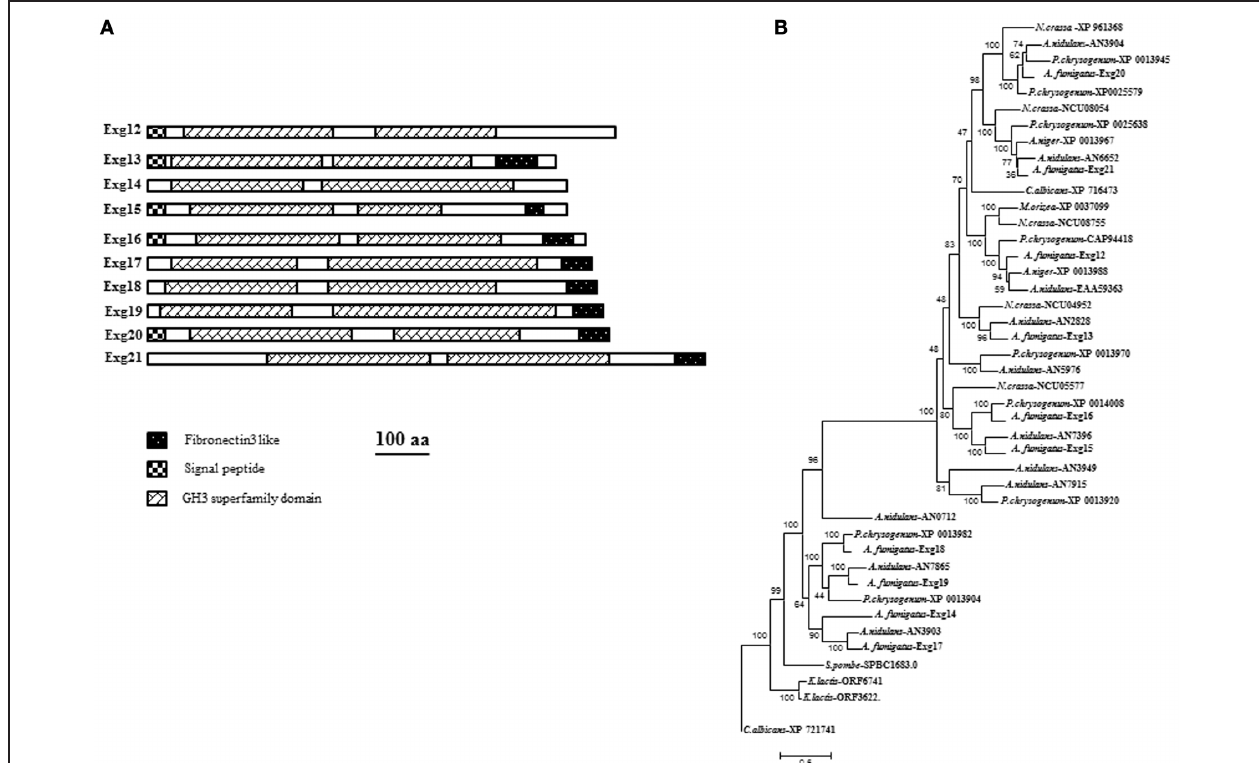
FIGURE 4 | (A) Domain organization of GH3 families of A. fumigatus . Protein domains identified using SignalP 3.0, big-PI, TMHMM v. 2.0, and CD search (100 aa: protein length proportional to 100 amino acids). and (B) Phylogenetic tree of β (1–3)glucanases GH3